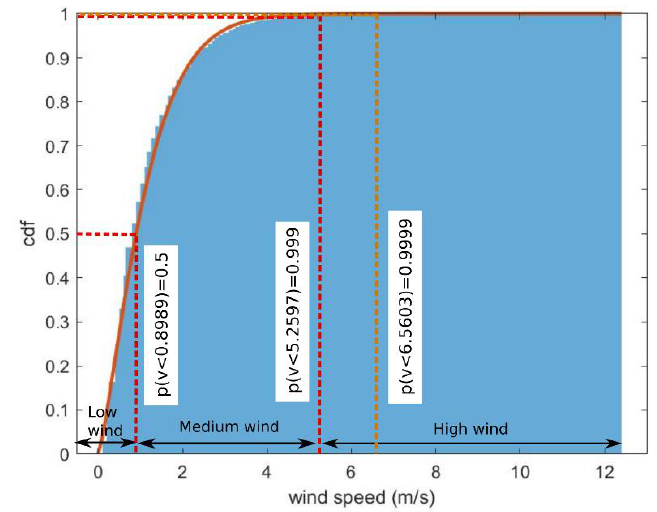
Figure 8. Wind speed cumulative distribution function (cdf) and Weibull distribution fit.